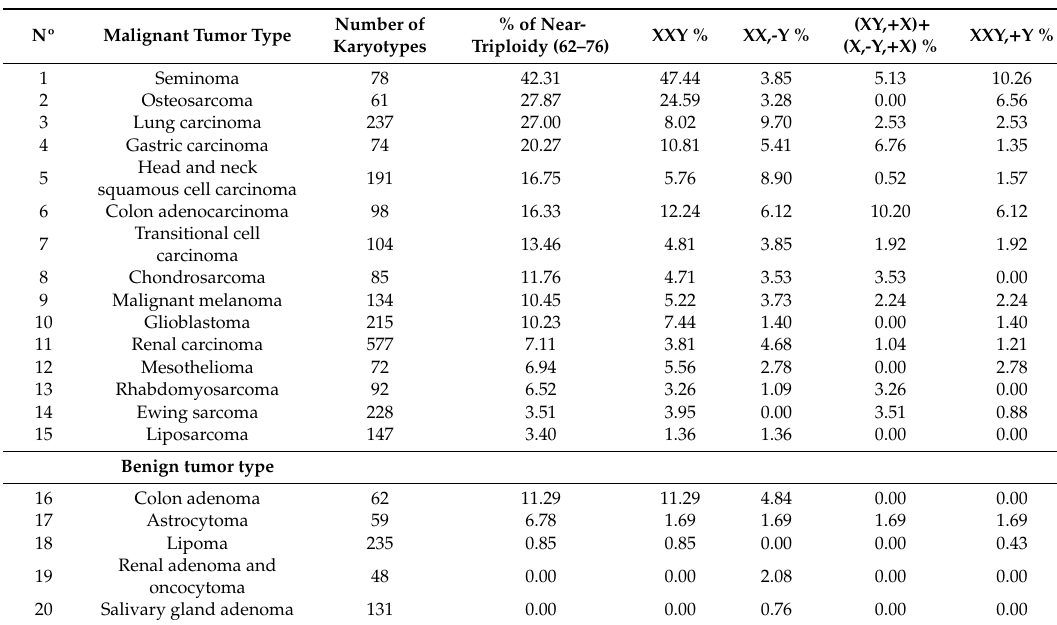
Table 1. The analyzed male tumor types, the number of karyotypes per cohort, the percentage share of near-triploidy (in the range of 62–76 chromosomes), and the percentage share of sex chromosome configurations containing a disomic X-chromosome. The karyotype XXY in most cases indicates near-triploidy with the three sex chromosome complement XXY. XX,-Y largely means a near-triploid karyotype from a male with the loss of the Y chromosome, where "-Y" indicates the third haploid chromosome set. Sex chromosomes XY, + X indicate a near-diploid male karyotype with the (not inherited) acquisition of the extra sex chromosome X. The diploid (or near-diploid) male karyotype X,-Y, + X means the (acquired) loss of sex chromosome Y and gain of sex chromosome X, while karyotype XXY, + Y is near-triploid by chromosome number, with a gain of chromosome